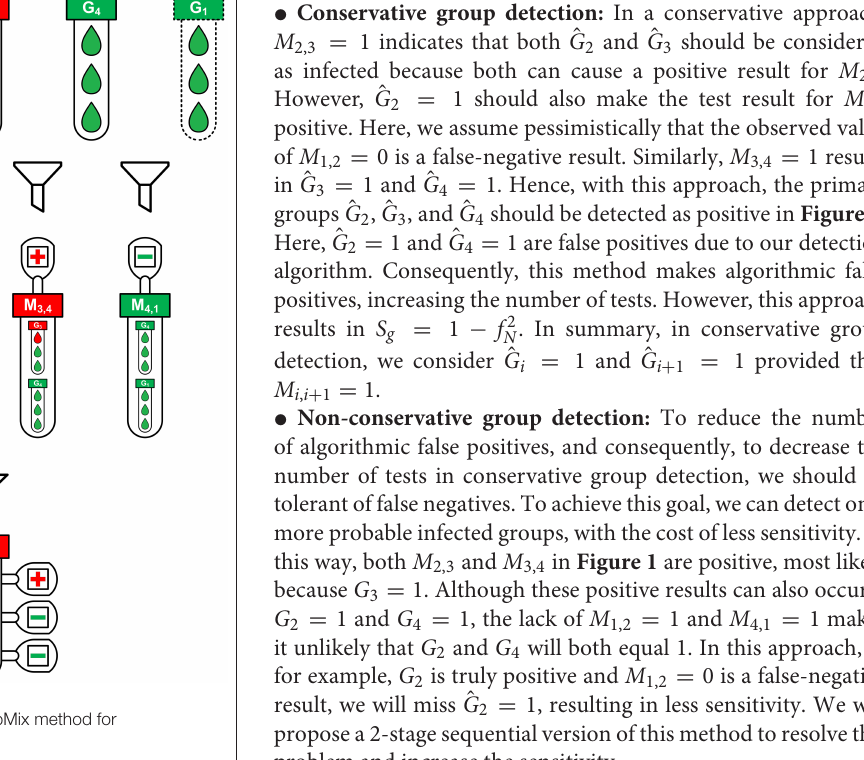
group testing, we compare S g values to measure the accuracy of the